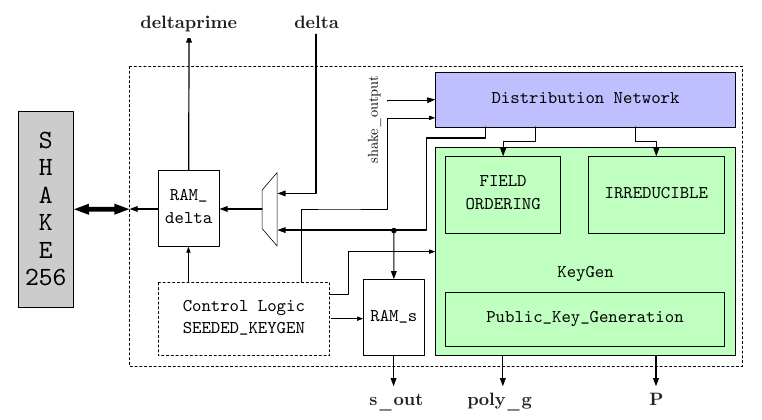
Figure 17: Hardware design of SeededKeyGen module interfaced with SHAKE256